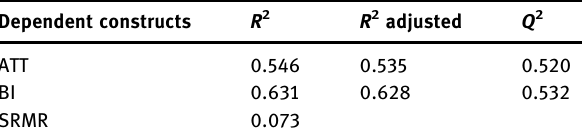
Table 5: Model fi t indices Dependent constructs